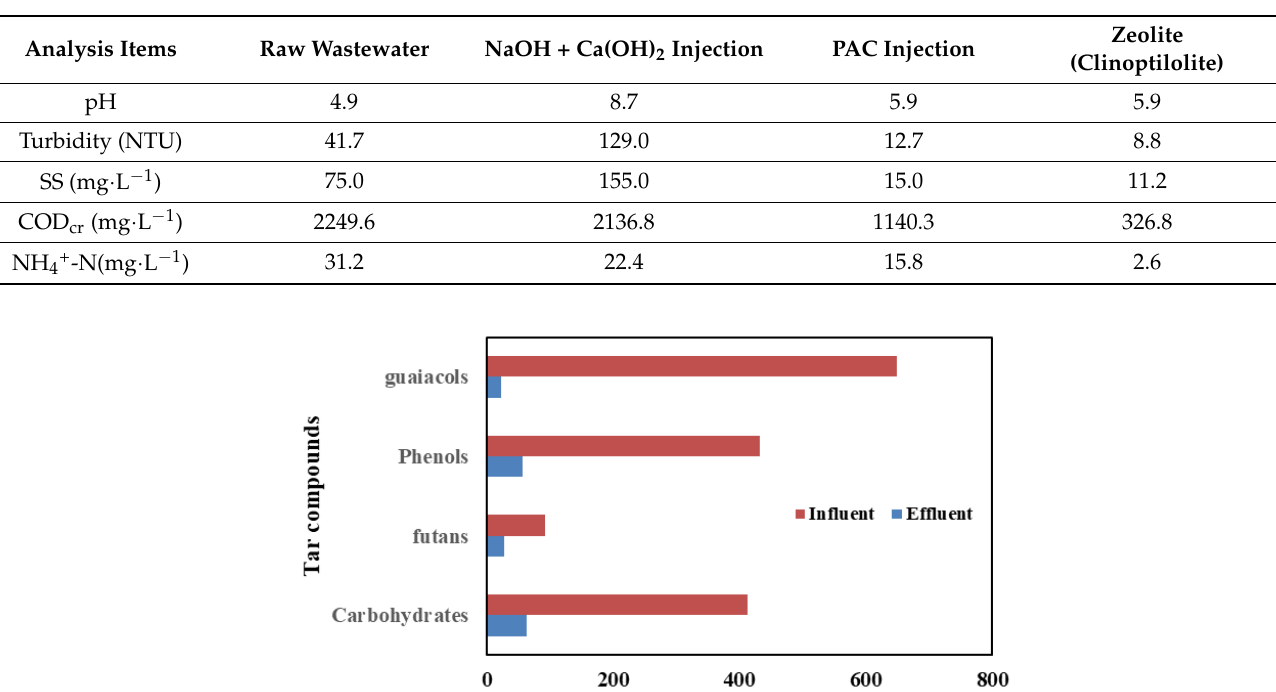
Table 3. Change in pH, turbidity, and SS contents at each processing step.